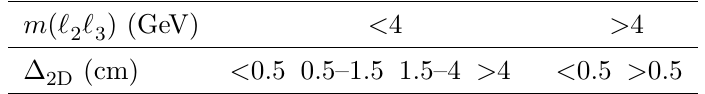
Table 2 . Definition of kinematic regions in terms of dilepton invariant mass m ( ‘ displacement ∆ 2D